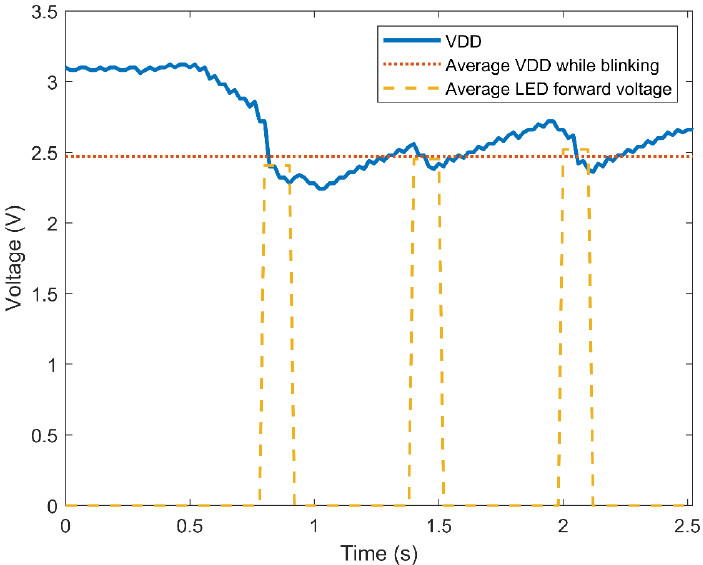
Figure 7. Supply voltage of the RFID tag while the LED is